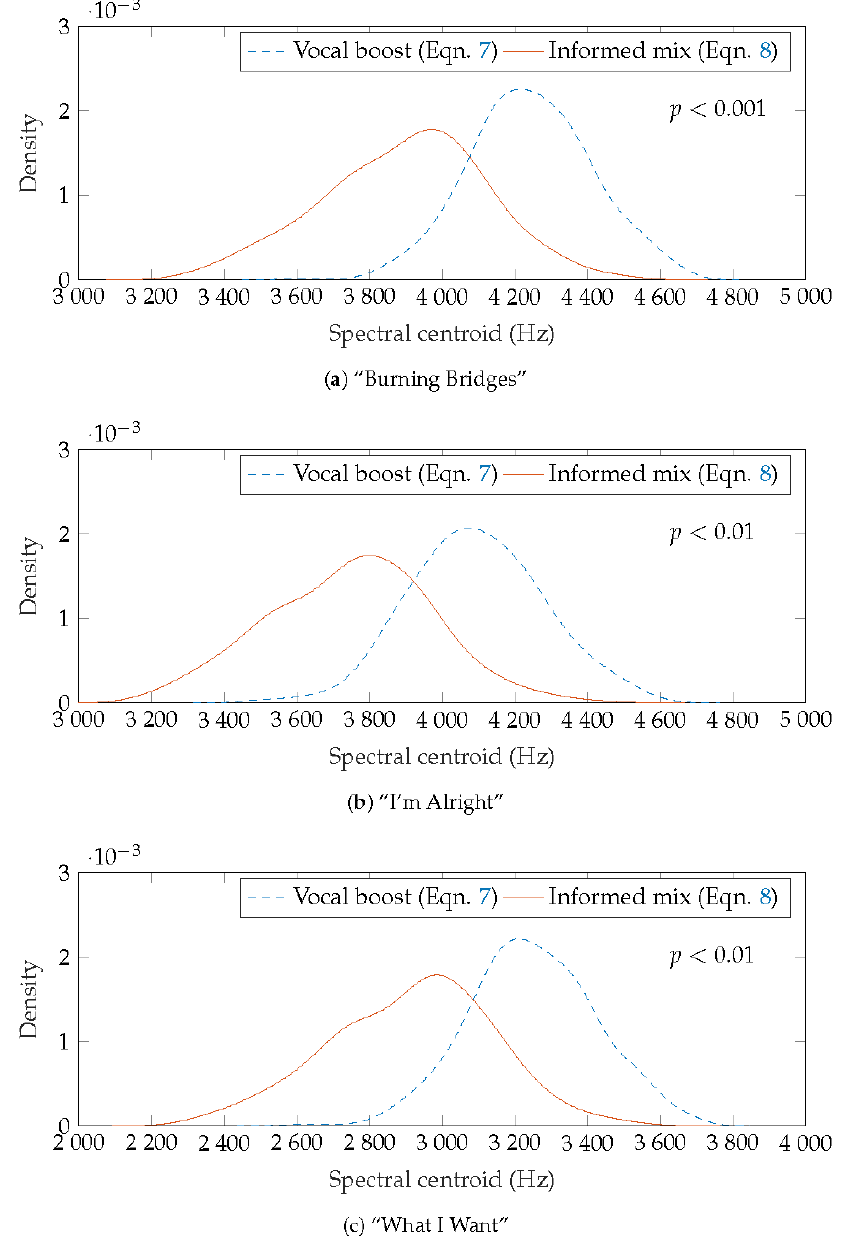
Figure 15. Probability distribution of spectral centroid as a function of mix-space parameters; ( a ) “Burning Bridges”; ( b ) “I’m Alright”; ( c ) “What I